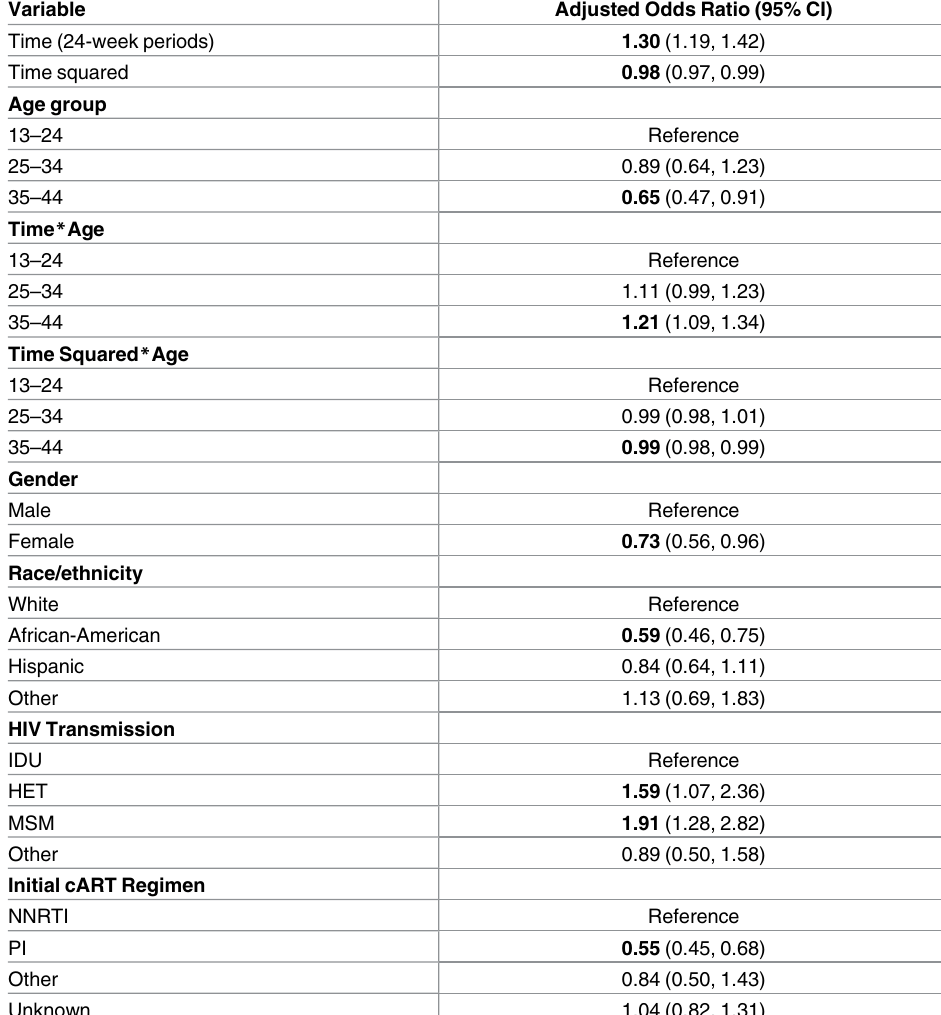
Table 4. Mixed Longitudinal Regression of Viral Load